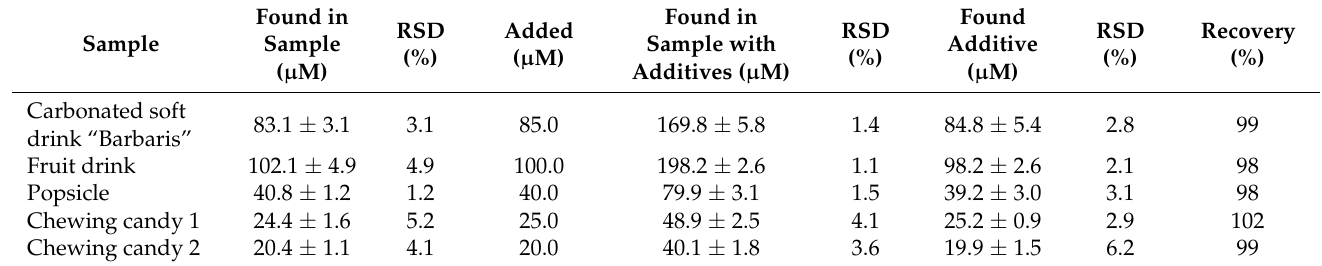
Table 2. The results of Ponceau 4R determination in real food samples (n = 5, p =